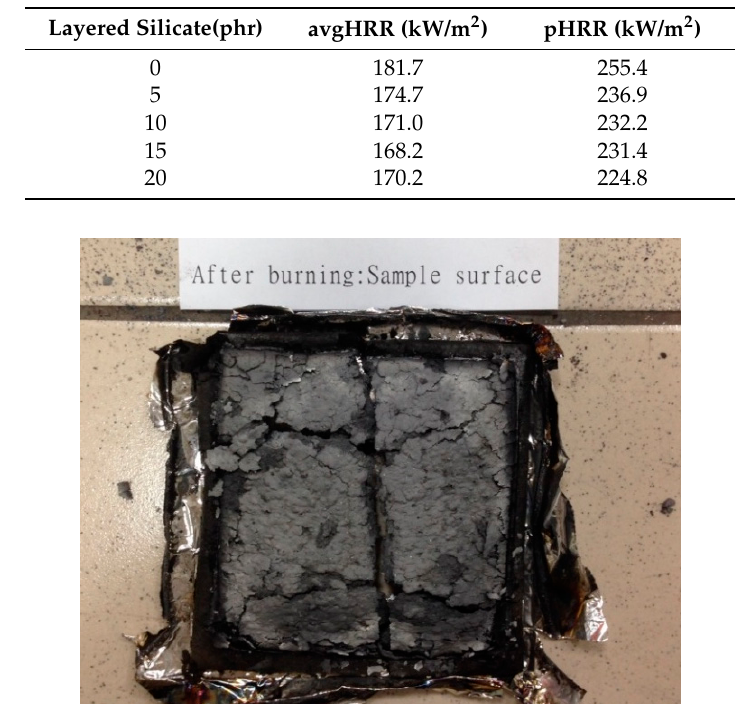
Figure 6. Typical heat release rate (HRR) curves for EPDM/CR nanorubbers with various layered-silicate contents. Table 2. Flammability properties of layered-silicate reinforced EPDM/CR nanorubbers.